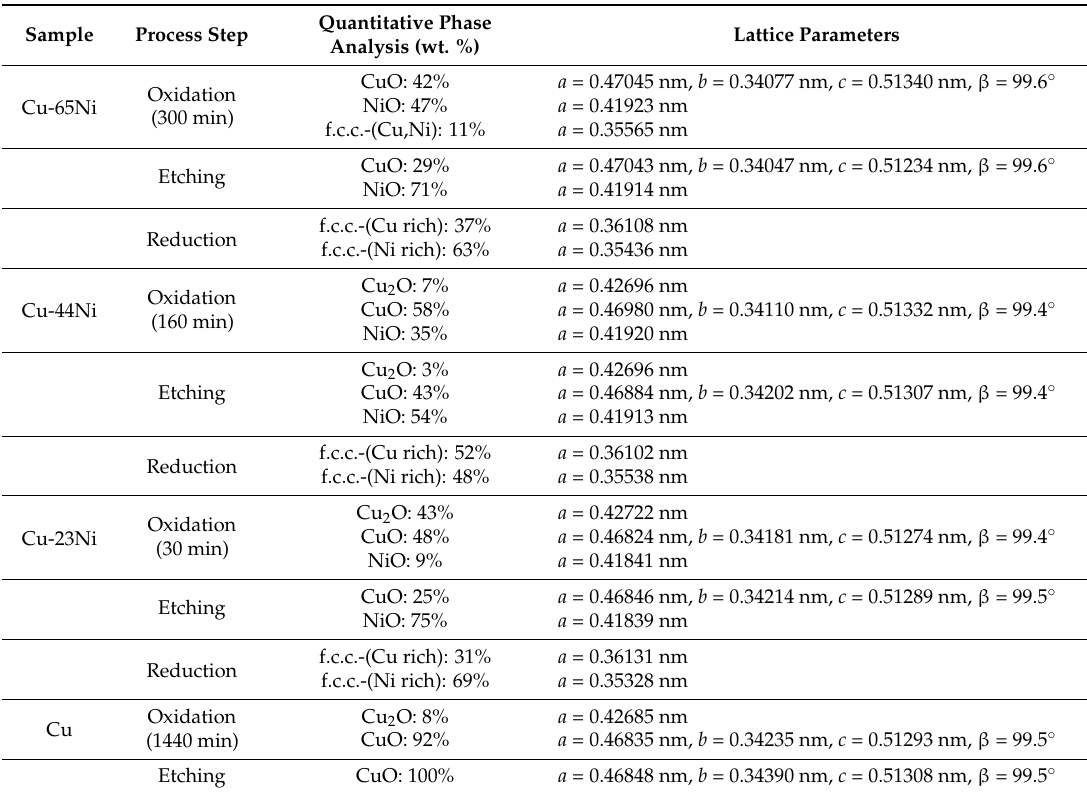
Figure 3a–d shows the SEM micrographs (backscattered electron detector) of the transversal cross sections of the oxidized wires. In the case of Cu-23Ni, Cu-44Ni and Cu-65 Ni, the cross section of